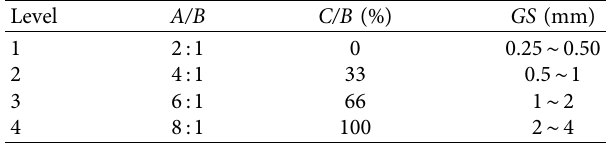
Table 2: Factors and levels in the orthogonal experiment.